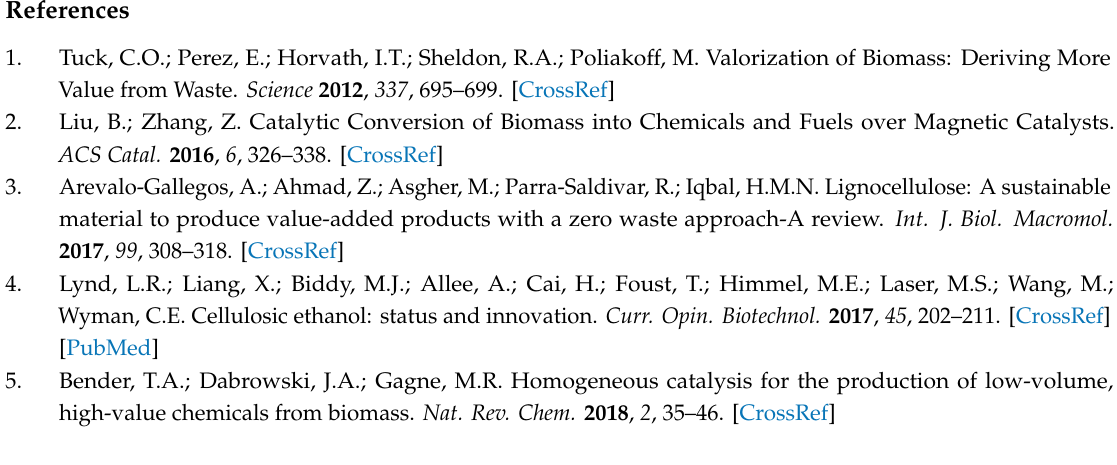
Figure S1: (a) FTIR spectrum and (b) XRD pattern of Keggin-type PMo 12 HPA, Figure S2: TEM images of (a) PAN, and (b) 40-PMo 12 / PAN, Figure S3: FTIR spectra of 40 -PMo 12 / PAN catalysts after reacting with di ff erent substances, Figure S4: TEM images of (a) F 3 -PAN, and (b) 40 -PMo 12 / F 3 -PAN, Figure S5: TG and DTG profiles of (a) fresh and (b) spent 40 -PMo 12 / F 3 -PAN catalysts, Scheme S1: Schematic illustration of the grafting of formyl groups on PAN support, Table S1: Preparation conditions of F y -PAN “supports” and the results resoluted from the FTIR spectra of F y -PAN and 40 -PMo 12 / F y -PAN, Table S2: Comparison of the production rates of several hybrid catalysts in the “one-pot” and “one-step” conversion of fructose to DFF, Table S3: The leaching of PMo 12 HPA during the recycled use of 40-PMo 12 / F 3 -PAN, Table S4: Recycled use of 40 -PMo 12 / F 3 -PAN catalyst in the “one-pot” and “one-step” conversion of fructose to